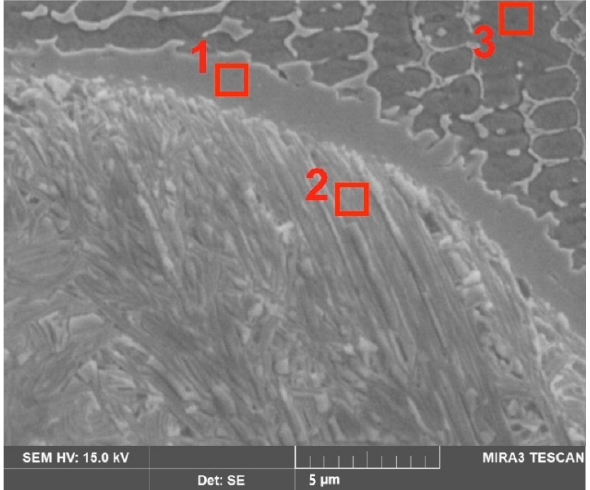
Figure 9. SE image of laser-alloyed layer produced with a laser beam power of 1.3 kW with marked areas in which EDS microanalysis was performed; 1—WC particle; 2—WC/matrix boundary; 3—matrix.